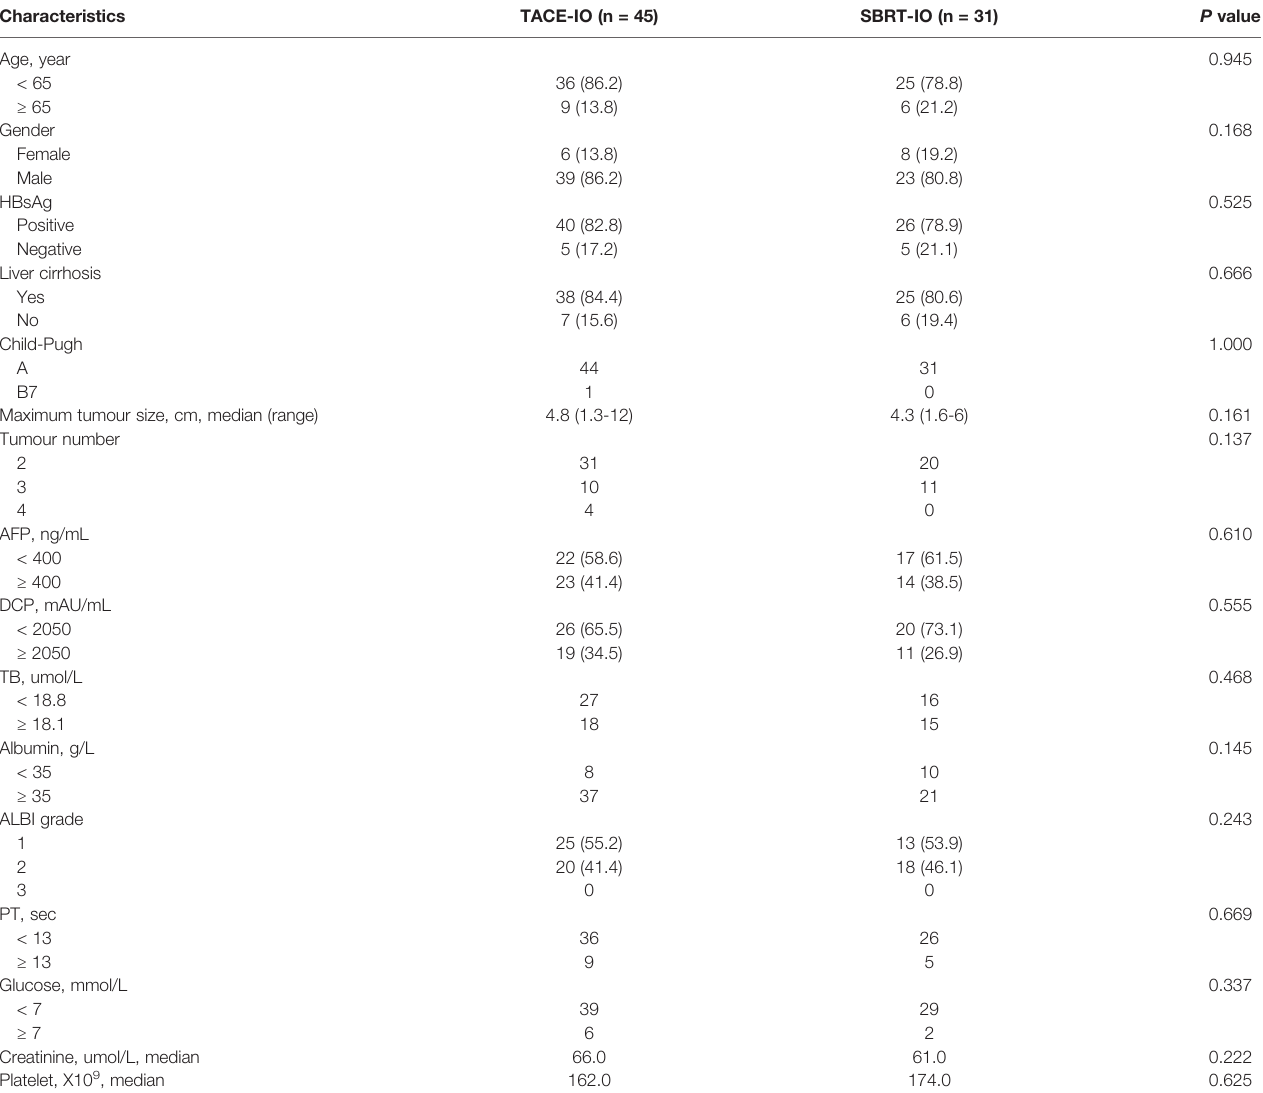
TABLE 1 | Baseline characteristics of study patients.